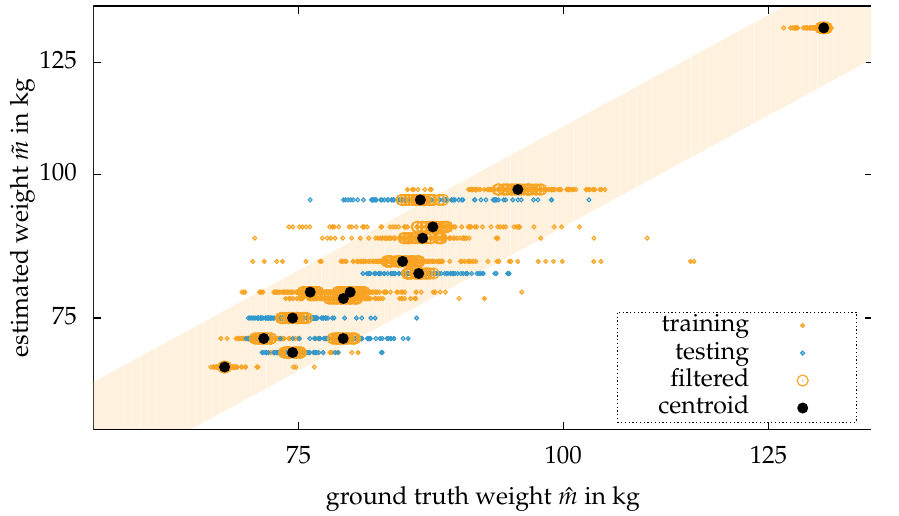
Figure 9. Results of the experiment with people walking towards the camera: The estimations for every frame for an arbitrary person generate a set of estimations, formed as a line together with the ground truth value in the scatter plot. Based on Euclidean clustering, 80 percent of the estimations are removed from the dataset. The final estimation is given based on the centroid of the remaining estimations. The orange area marks the range for the relative error of ± 10